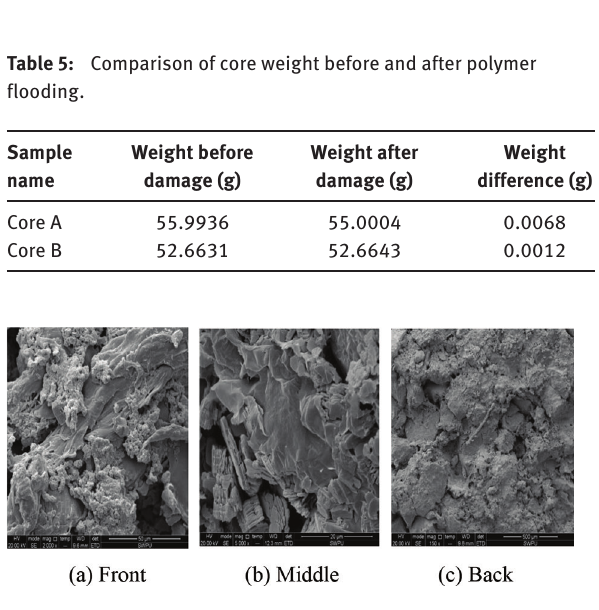
Figure 4: Microscopic structure of core A.